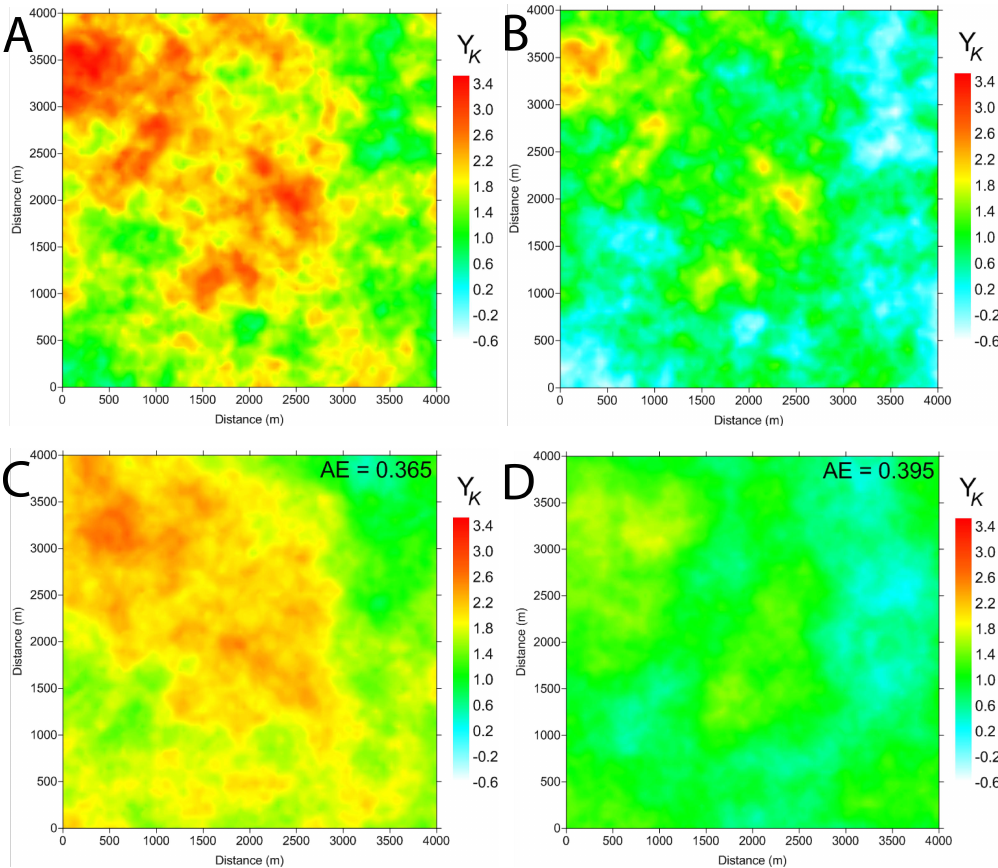
Fig. 11. (A) True Y K field using µ y =1.801 log m day − 1 ( K = 63 . 2 m day-1), (B) True Y K field using µ y K day-1), (C) mean distribution of the updated Y K ensemble for the first scenario (µ y ensemble for the second scenario (µ y =0.801). For both scenarios scenario, 24 WT data from four assimilation times are K